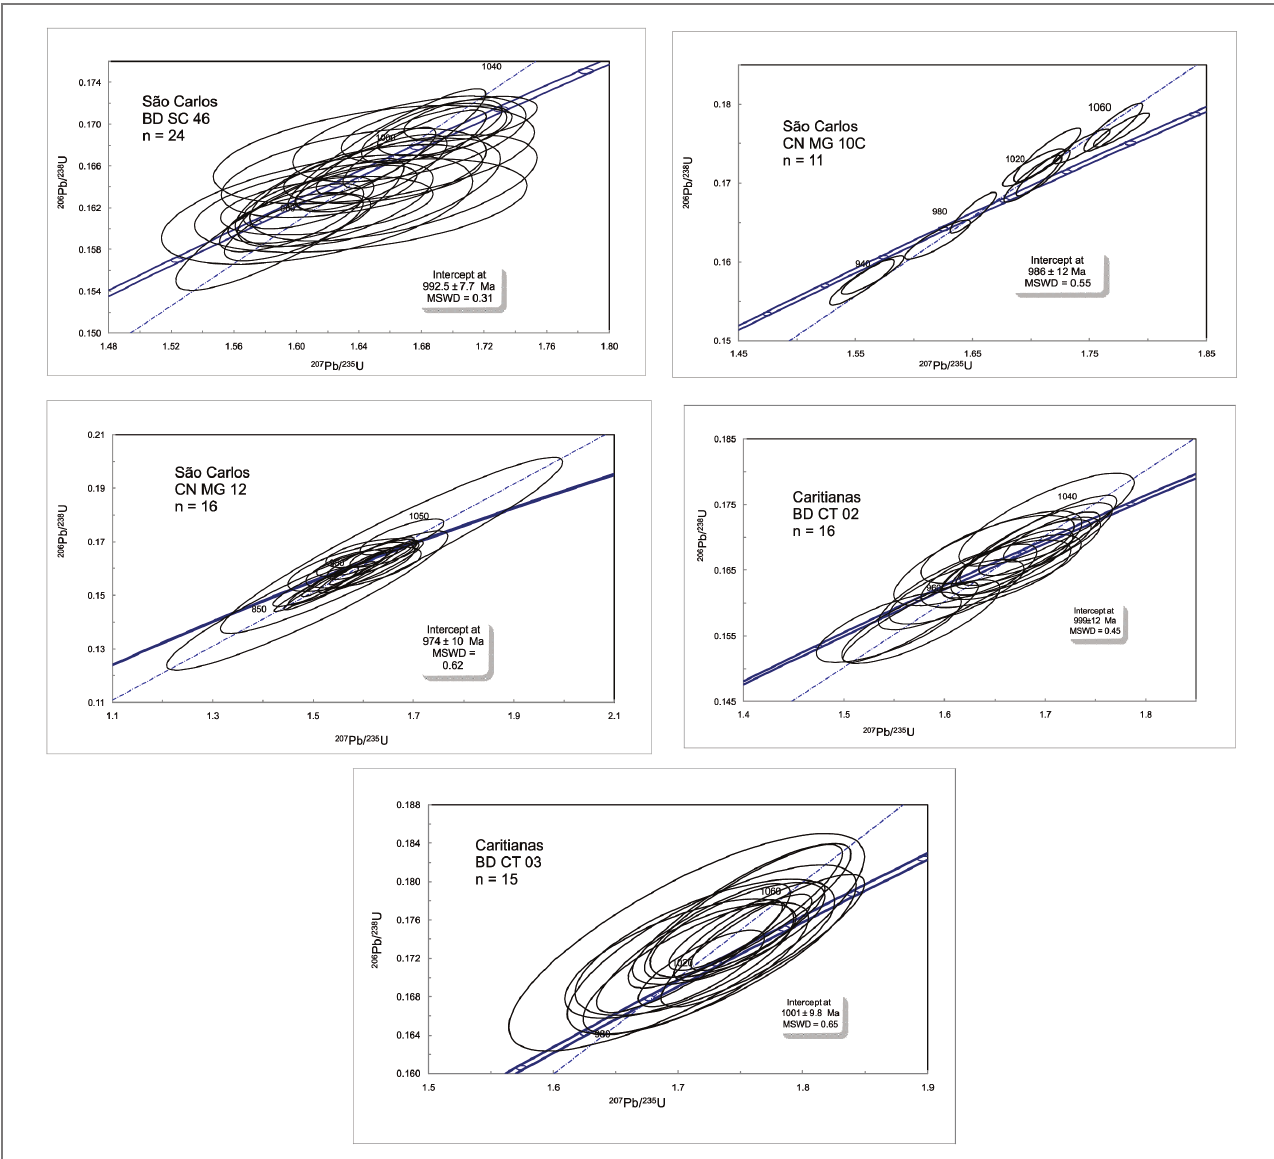
FIGURE 6 – Concordia diagram showing U-Pb ages in zircon grains from the Massangana, São Carlos and Caritianas